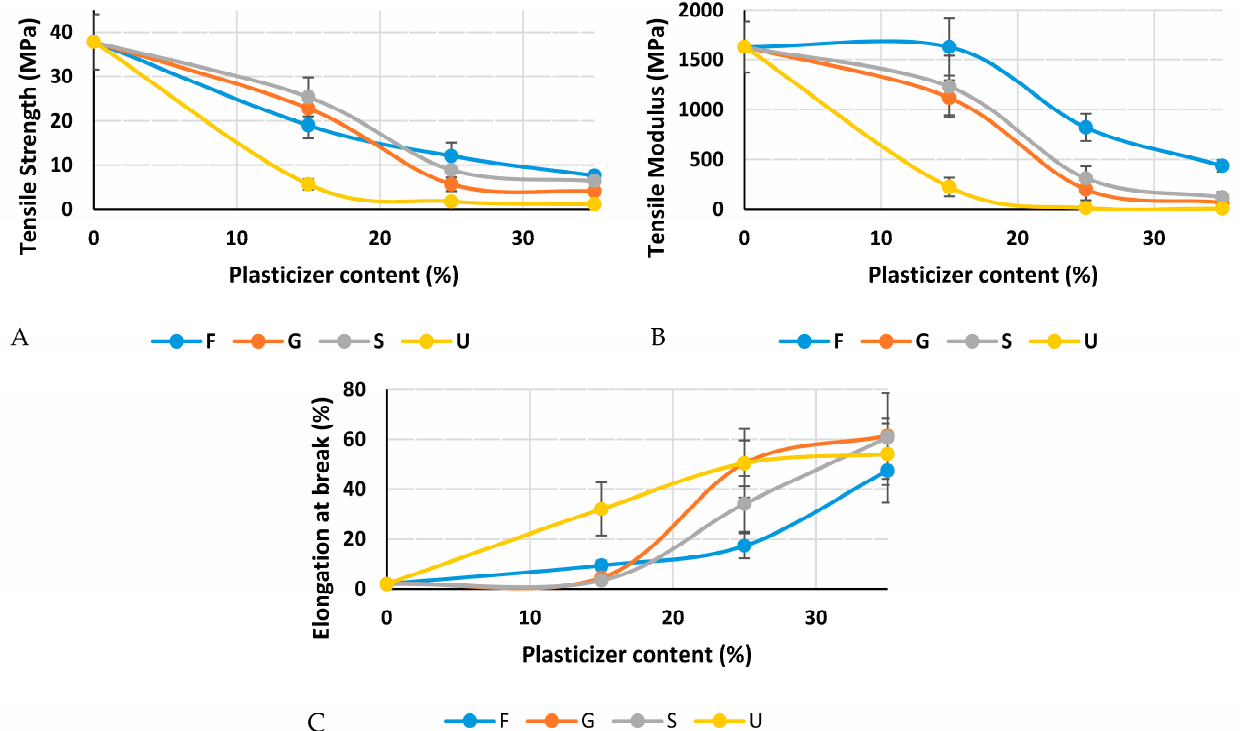
Figure 10. Mechanical properties of wheat starch plasticized films. ( A ) Tensile Strength, ( B ) Tensile Modulus and ( C ) Elongation at break. 0% is the control film.